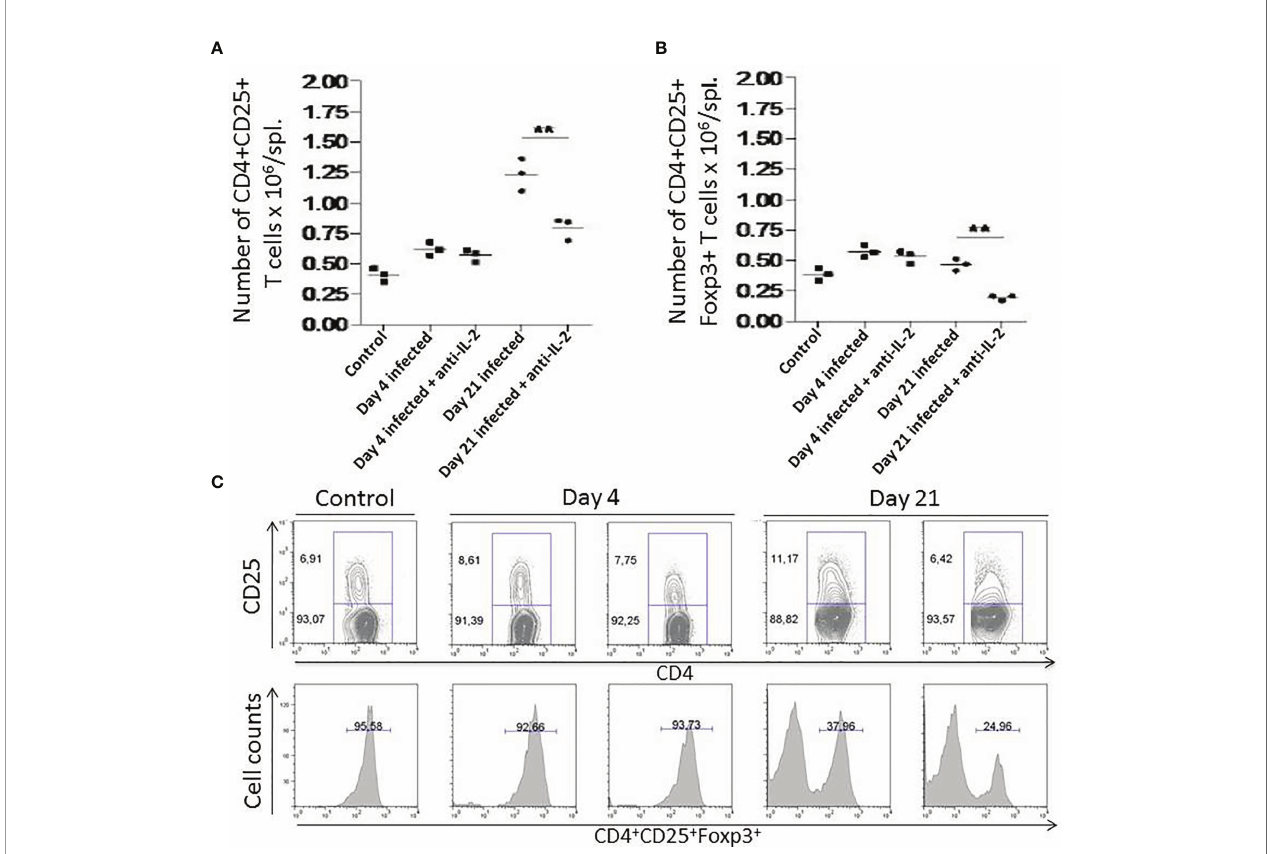
FIGURE 6 | Numbers of splenic CD4 + CD25 + and CD4 + CD25 + Foxp3 + T cells after In vivo administration of anti-IL-2 mAb. In Figure 6 , total numbers of splenic CD4 + CD25 + (A) and CD4 + CD25 + Foxp3 + T cells (B) are shown. Days 4 and 21 after infection are compared with uninfected controls. Mice that received anti-IL-2 mAb treatment were compared with uninfected or infected mice treated with rat Ig. Rat Ig treatment did not produce differences concerning control PBS-treated mice (not shown). (C) (upper panel) shows representative plots of gated splenic CD4 + CD25 + T cell population after in vivo treatment with anti-IL-2 mAb treated mice after different time-points post-infection compared to controls. Representative histograms ( C , lower panel) from 3 pooled spleen cells per group of mice show the percentage of Foxp3 + cells inside gated CD4 + CD25 + T cells compared in distinct time-points after infection. Experiments were repeated on three occasions with similar results (**P < 0.01, n = 3 group, Mann-Whitney